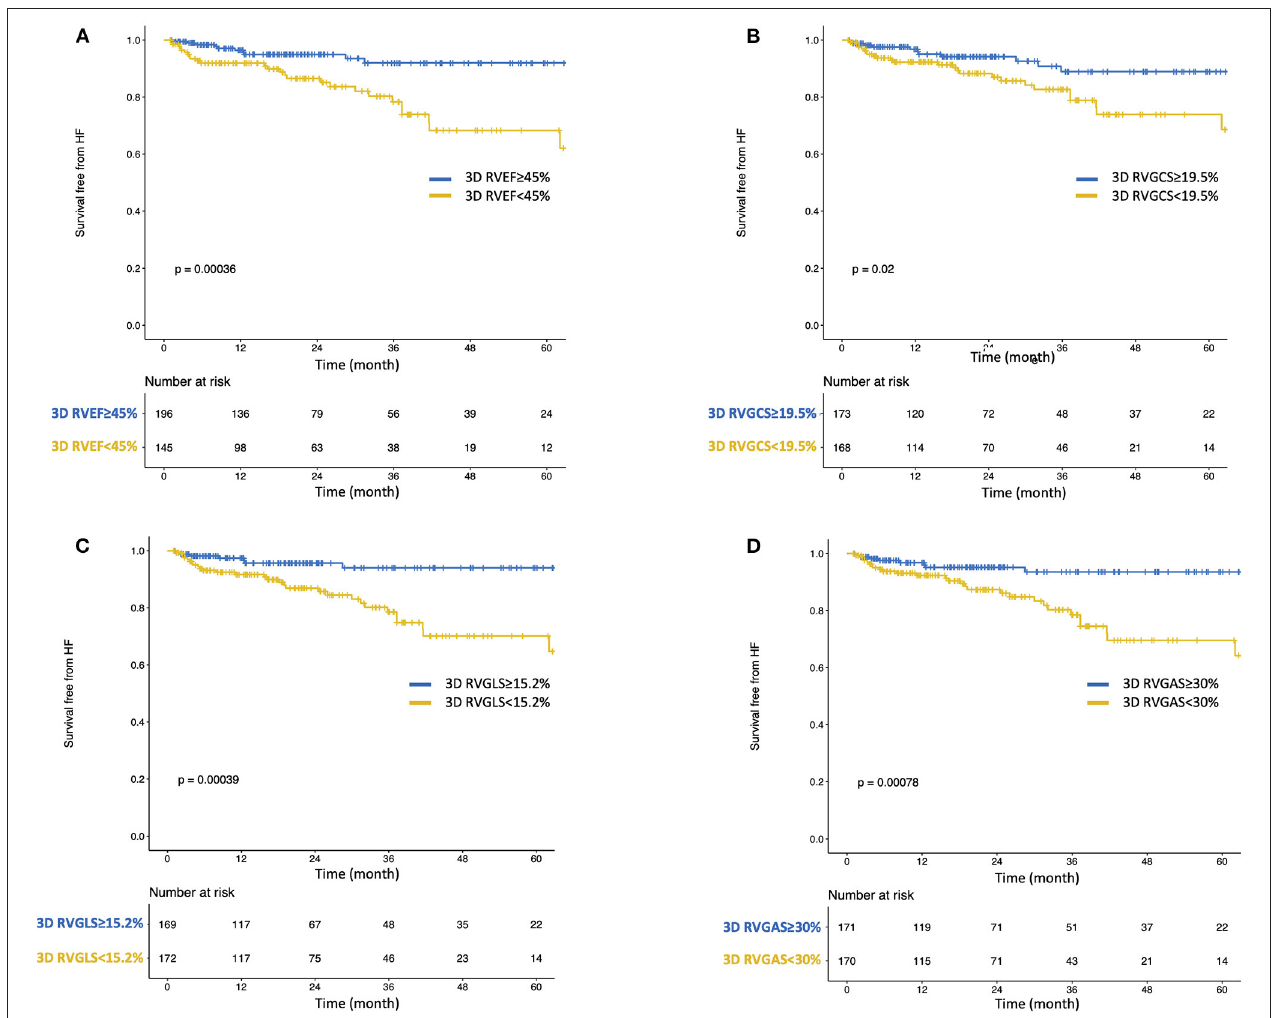
FIGURE 6 | Kaplan-Meier survival curves for heart failure hospitalization stratified by predefined cut-off value of 3D RVEF (A) and median values of 3D RVGCS (B) , 3D RVGLS (C) , and 3D RVGAS (D)